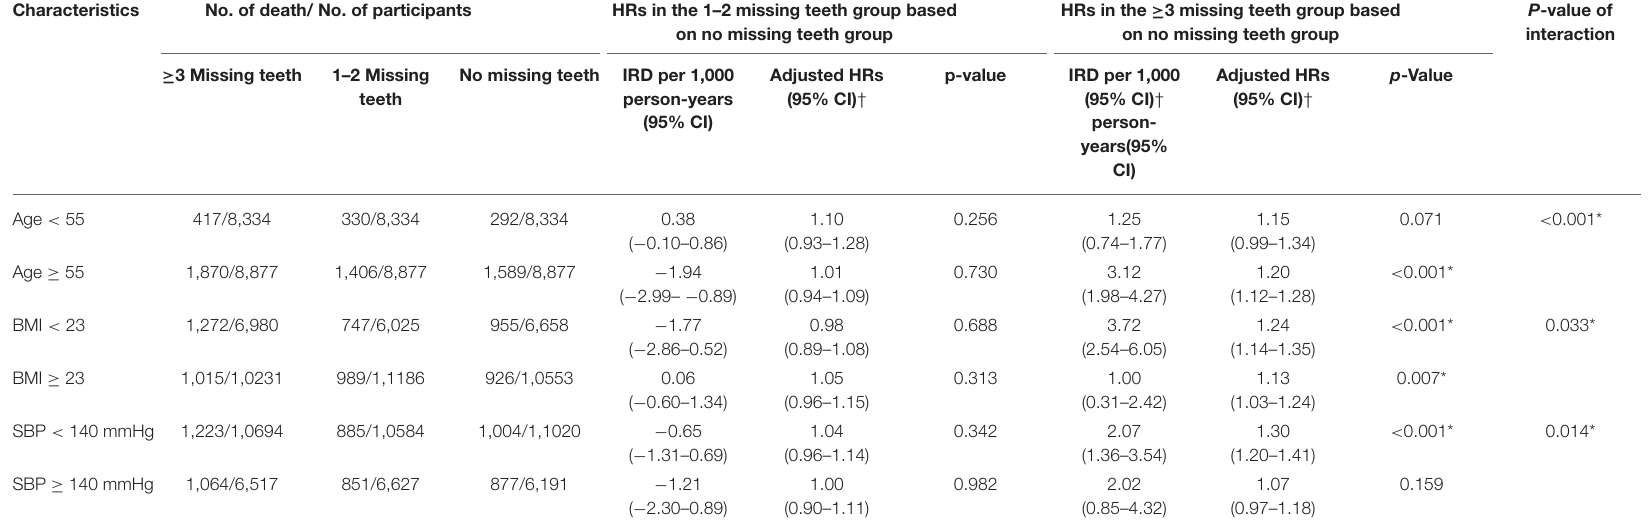
TABLE 3 | Association between the number of missing teeth with all-cause mortality in subgroups of age, obesity, and SBP.